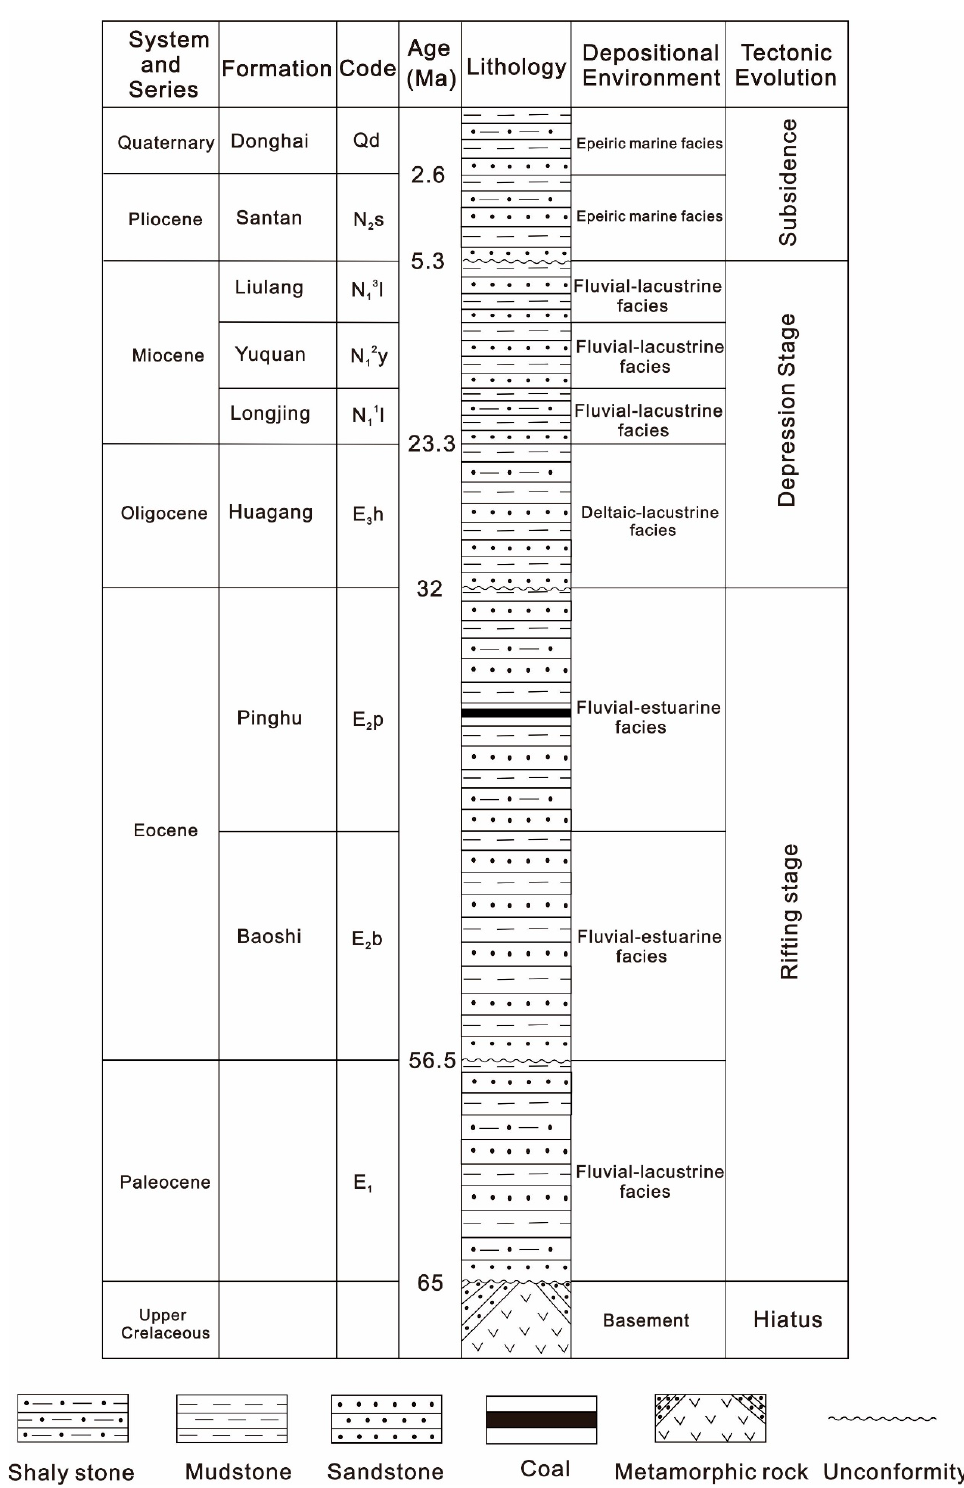
Figure 2. Stratigraphy, deposition, and tectonic evolution in the Xihu Sag (modified after Su